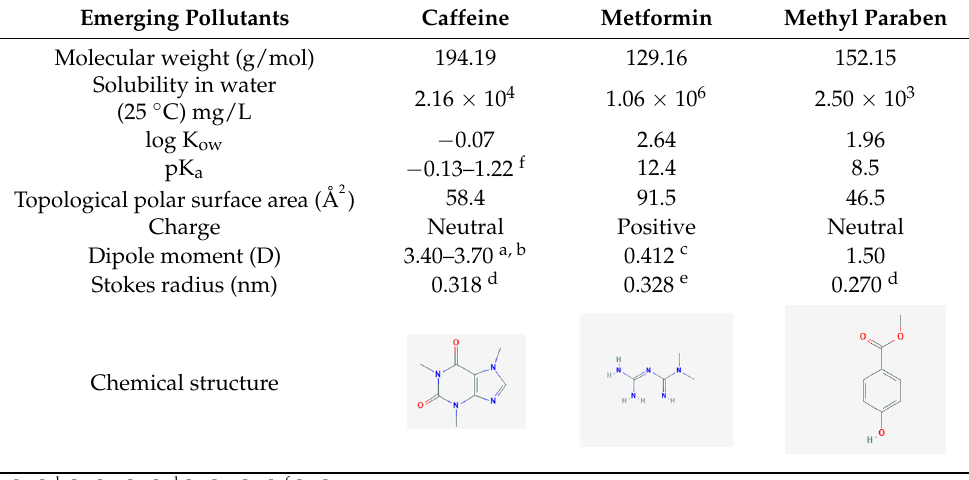
Table 3. Physicochemical properties of the emerging pollutants studied.